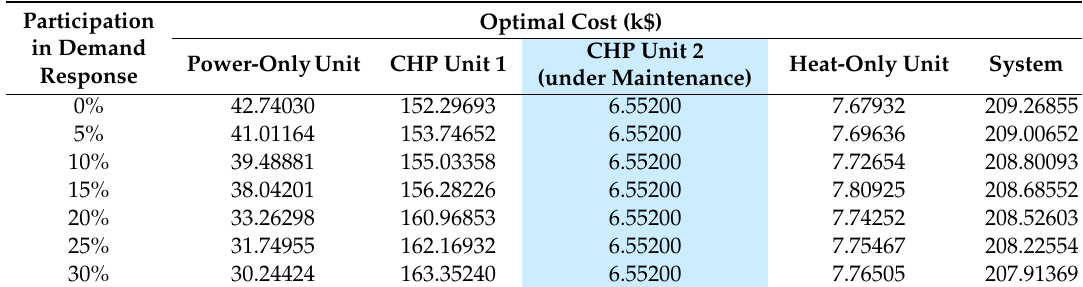
Table 8. The units’ cost for di ff erent participation percent in demand response for a typical day in week